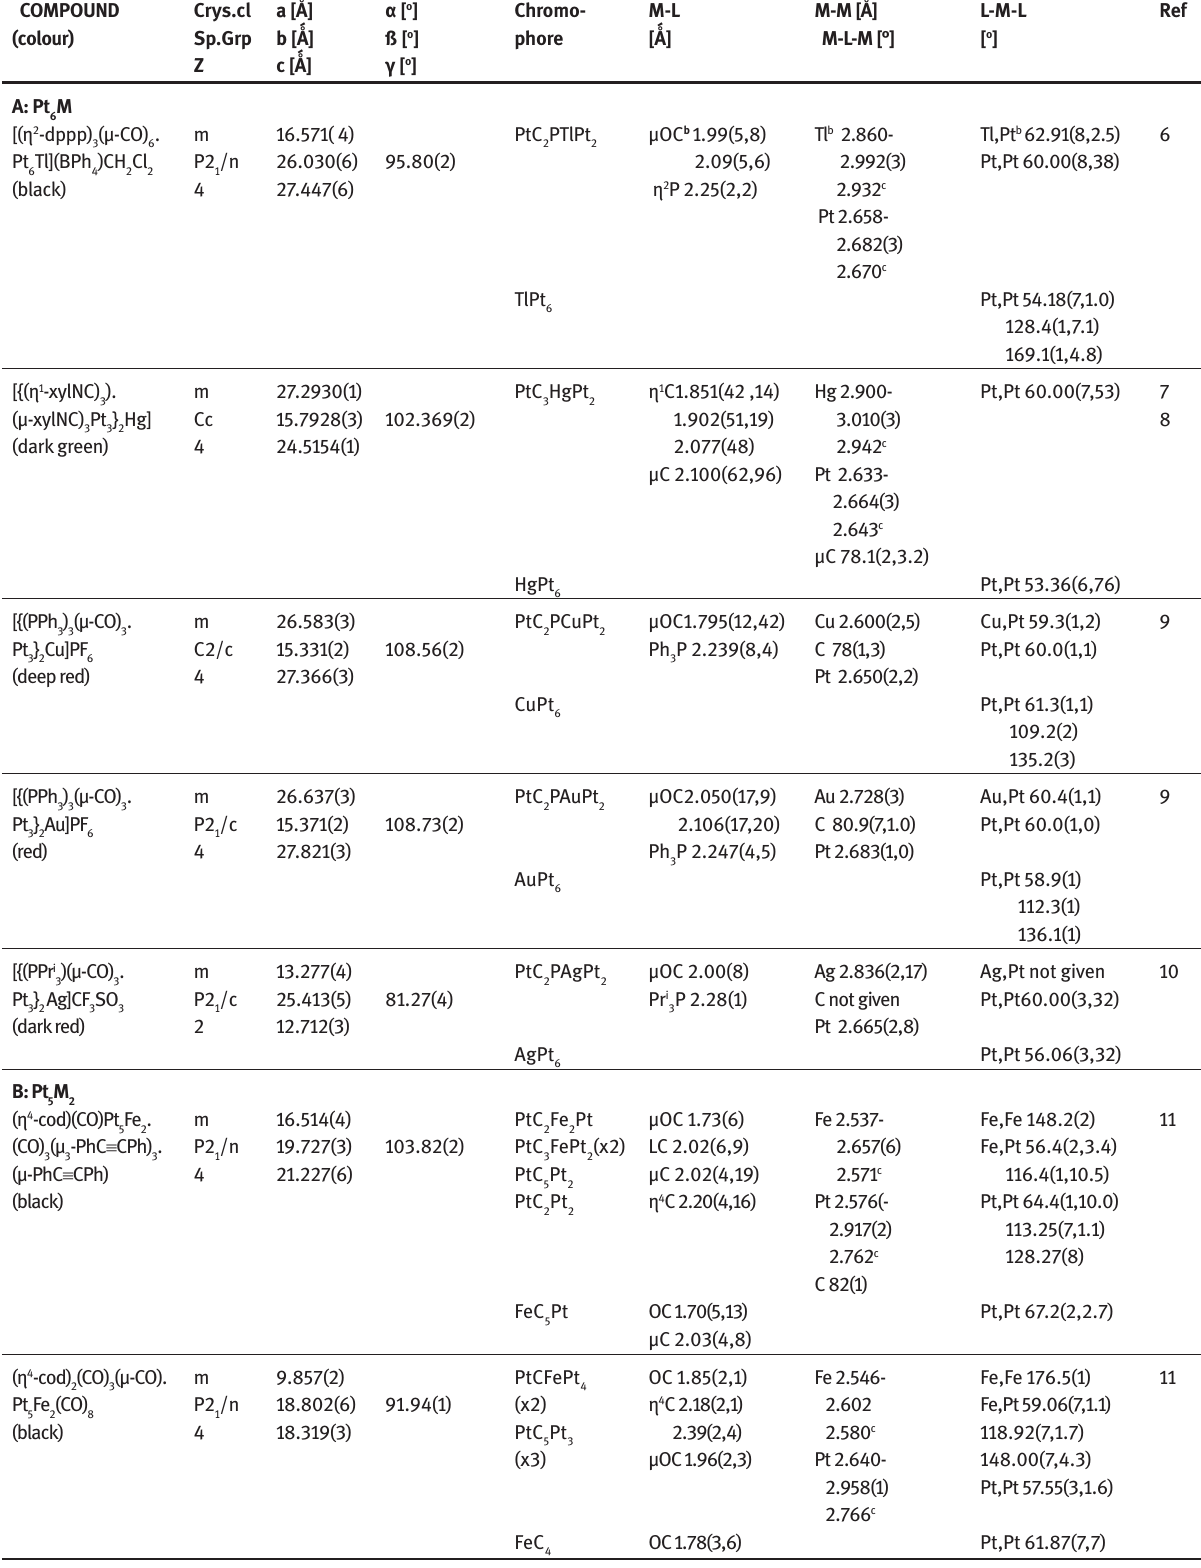
Table 1. Crystallographic and structural data for heteroheptanuclear platinum clusters a .